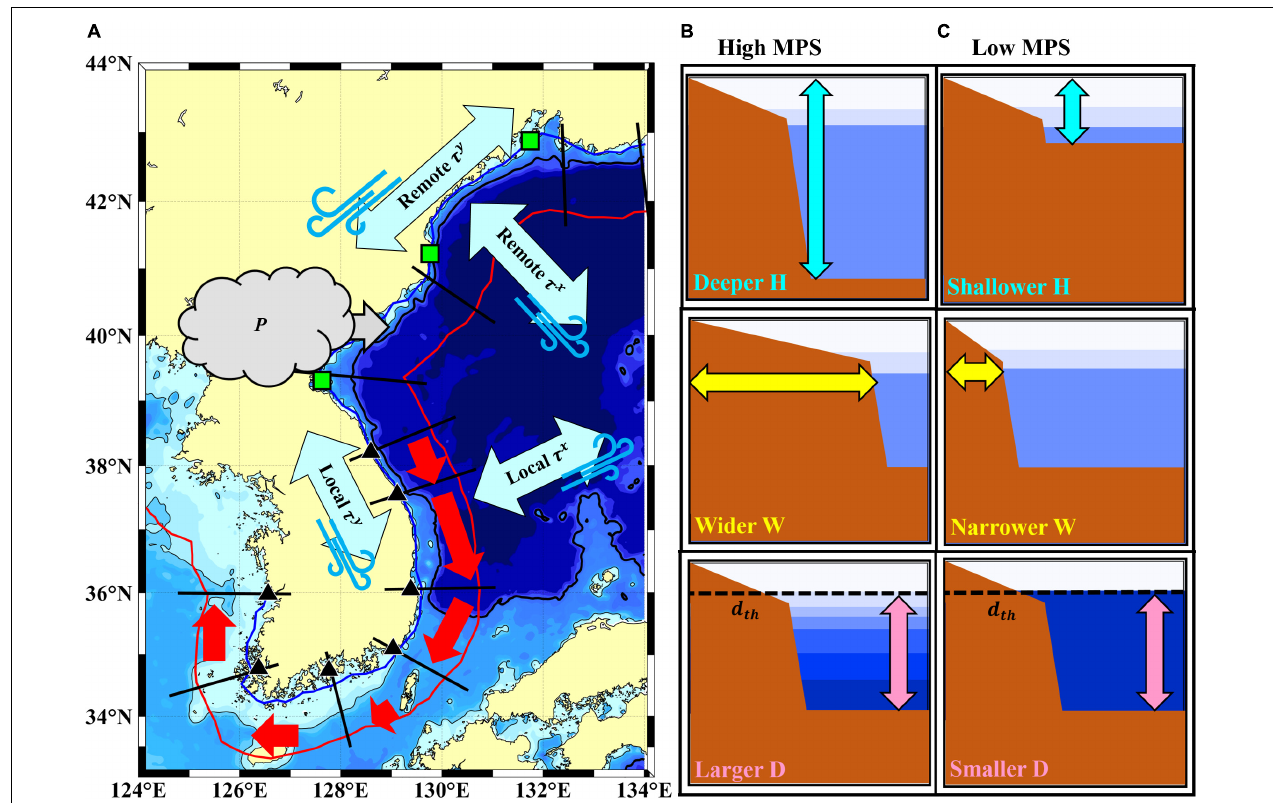
FIGURE 12 | Schematic figures for the subtidal sea level fluctuation propagating around the KP and their relevant mechanisms. In the left panel (A) , the causative forcing factors affecting the subtidal sea level fluctuation discussed in this study are denoted with gray ( P, atmospheric pressure loading) and sky-blue arrows ( τ y and τ x , alongshore and cross-shore wind forcing). The alongshore variations in the observed propagation speed of the subtidal sea level fluctuations are also represented with red arrows around the coastline of KP. In the right panels, the conditions for (B) the high MPS and (C) the low MPS following mode-1 CTWs dynamics are shown, i.e., water depth ( H ), shelf width ( W ), and the vertical density difference ( D ) between the lower boundary of the seasonal thermocline ( d th ) and the